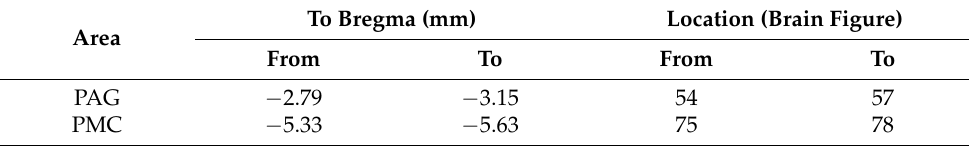
Table 1. Dissection of specialized brain regions. To Bregma (mm) Location (Brain Figure) Area From To From To